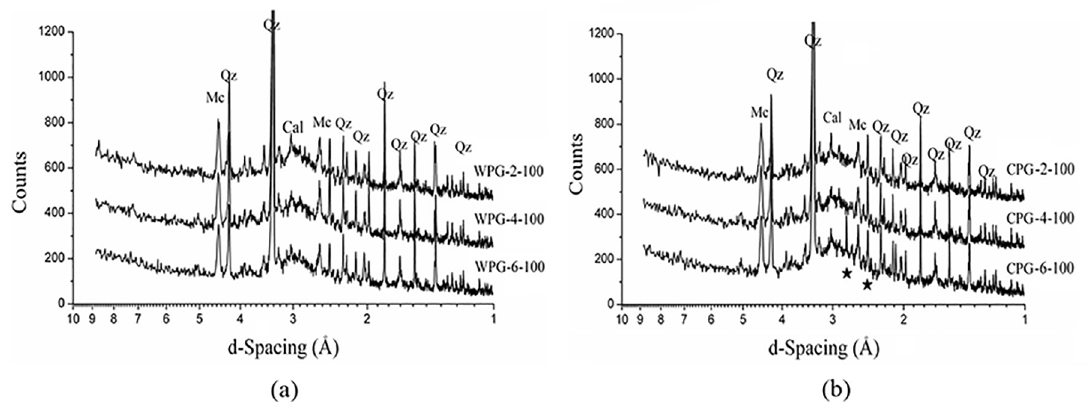
Figure 7. XRD of synthesized geopolymer resins evaluating the calcination time of the phyllites white (a) and cream (b), where indicates formation of new crystalline phase in the unidentified CPG-6-100.